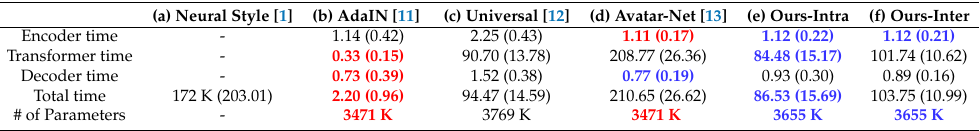
Table 3. The average (standard deviation) elapsed time (ms) per each module and the number of total parameters in the image style transfer methods. The red and blue colored values represent the best and the second best performances